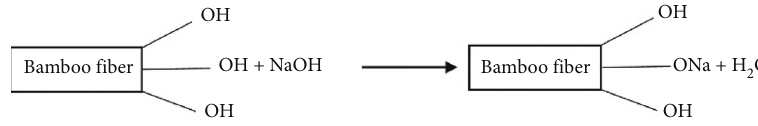
Figure 2: Chemical reaction during alkaline treatment